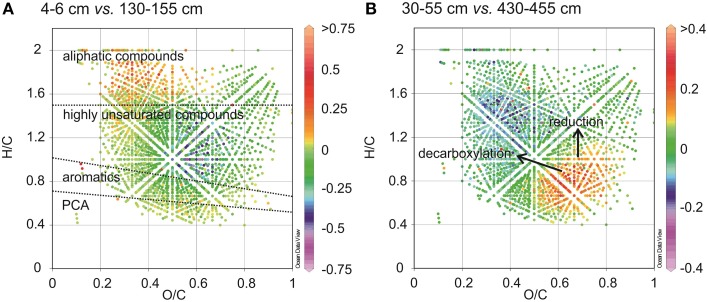
Differential van Krevelen diagrams compare the relative formula intensities of CHO compounds between two samples showing molecular variations between surface and subsurface sediments (A), and between two subsurface sediments (B). Higher formula intensities in each of the shallower samples relative to the deeper samples is indicated by positive values (orange to red color) whereas negative values (blue to purple color) indicate higher formula intensities in the deeper samples relative to the shallow ones.